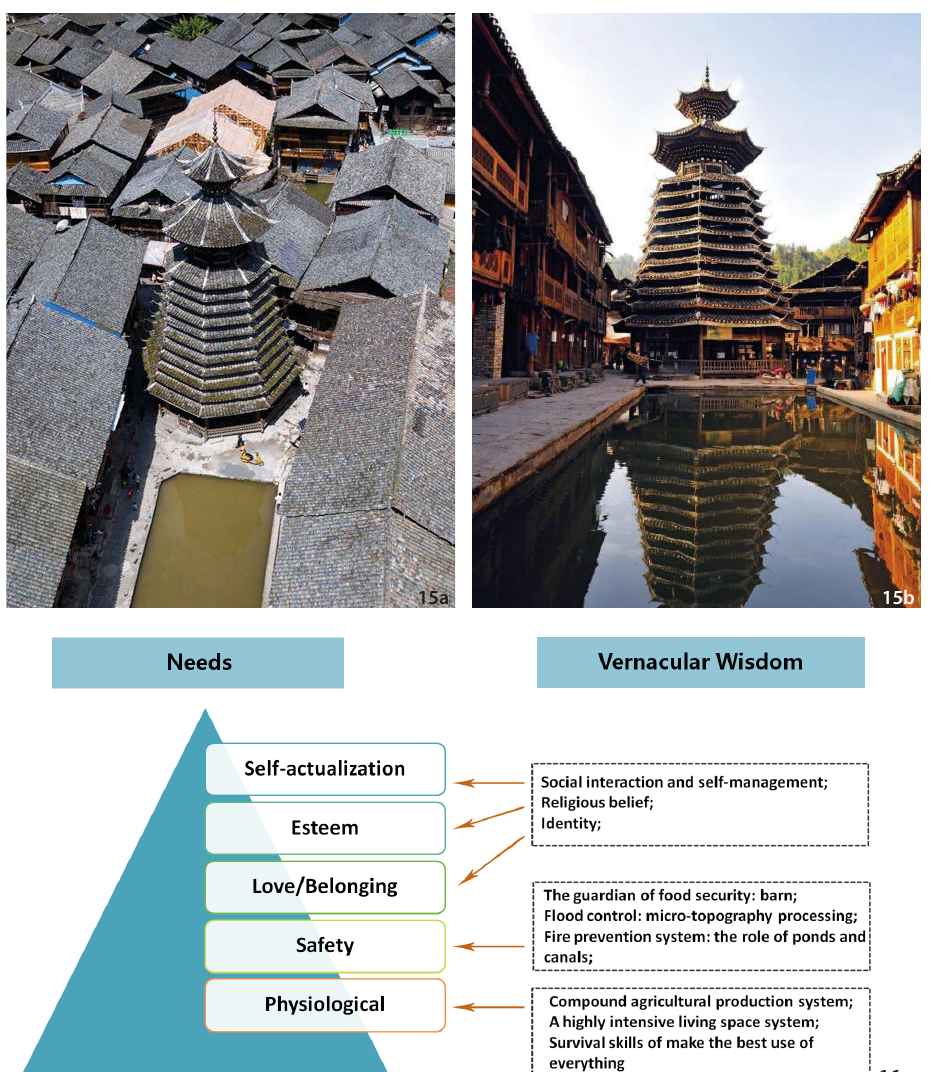
Figure 15a and 15b The Drum Tower with multiple functions and symbolism in Zengchong Village (Source: